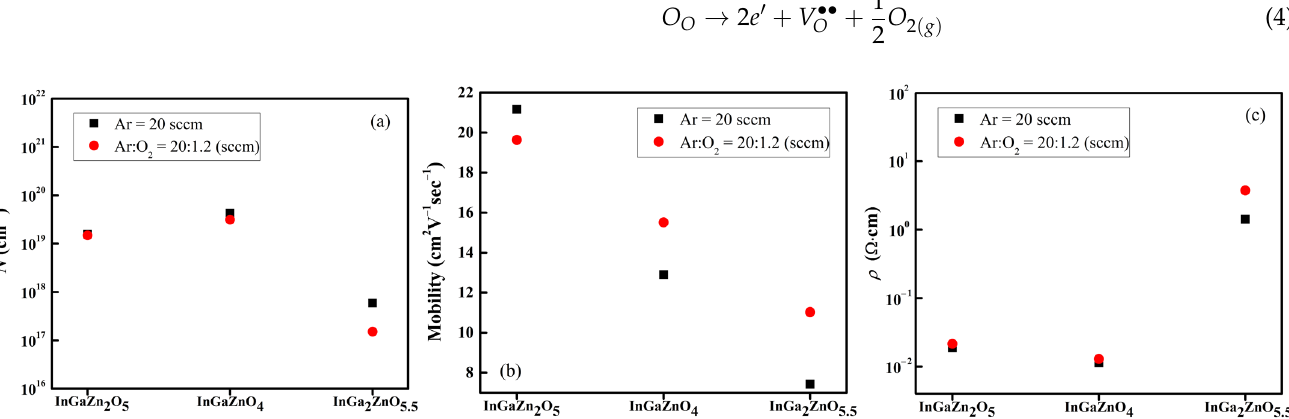
Figure 6. Hall effect measurement of ( a ) N , ( b ) μ Hall , and ( c ) ρ of the various a -IGZO thin films with Ar = 20 sccm and Ar:O 2 = 20:1.2 (sccm). Table 2. Hall measurement result of the various a -IGZO thin films with Ar = 20 sccm. a -IGZO Layer Type